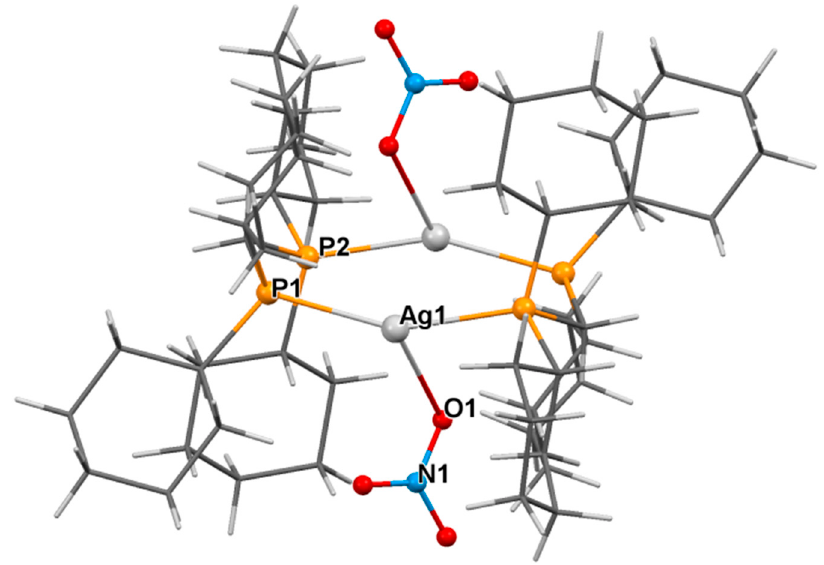
Figure 1. X-ray diffraction (XRD) structure of complex 1 (carbon and hydrogen atoms are shown as sticks).